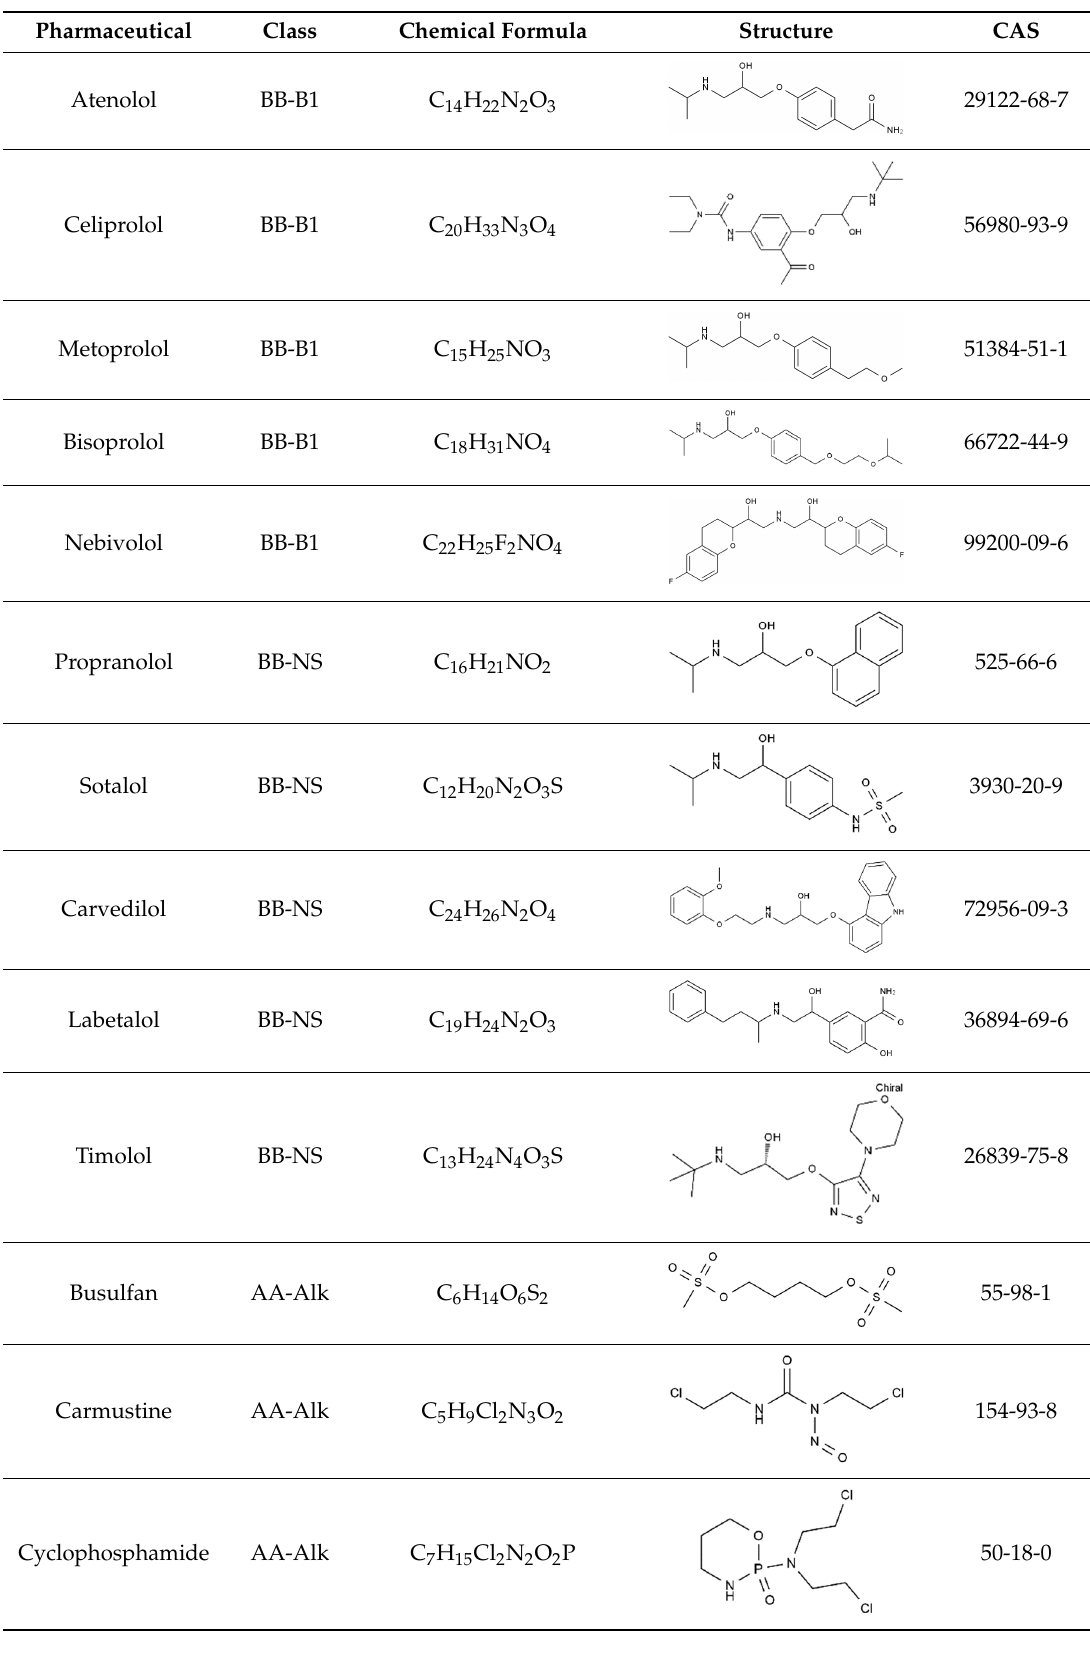
Table 1. Examples of frequently used beta blockers and antineoplastic agents.